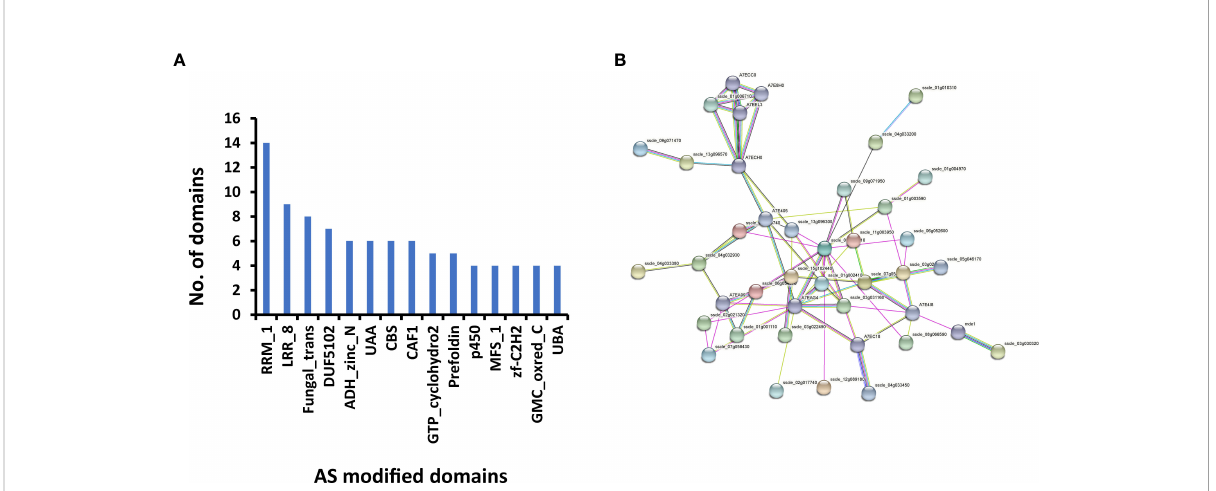
FIGURE 4 Differential alternative splicing genes (DASGs) with modi fi ed functions in S. sclerotiorum . (A) Fifteen most frequently modi fi ed domains in DASGs. (B) The network was constructed using STRING (https://string-db.org/). There are 41 protein nodes and 73 protein – protein association edges in the network. Seven differently colored lines represent the types of evidence used in predicting associations. Light blue line, database evidence; purple line, experimental evidence; green line, neighborhood evidence; blue line, co-occurrence evidence; yellow line, text mining evidence; black line, co-expression evidence; and dark blue lines, protein homology